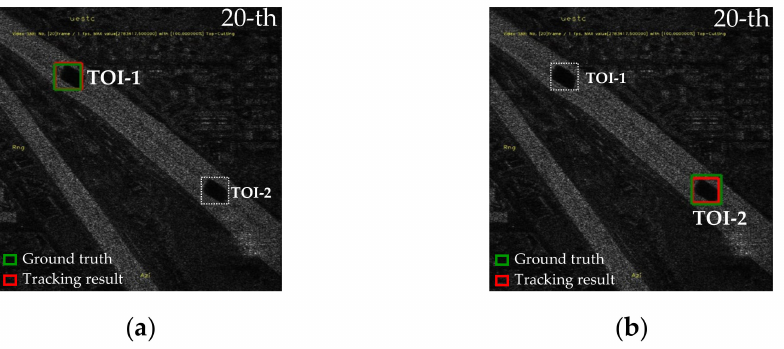
Figure 17. Tracking results of the target with a specific speed: ( a ) TOI-1 in the 20th frame of Video 5; ( b ) TOI-2 in the 20th frame of Video 5.